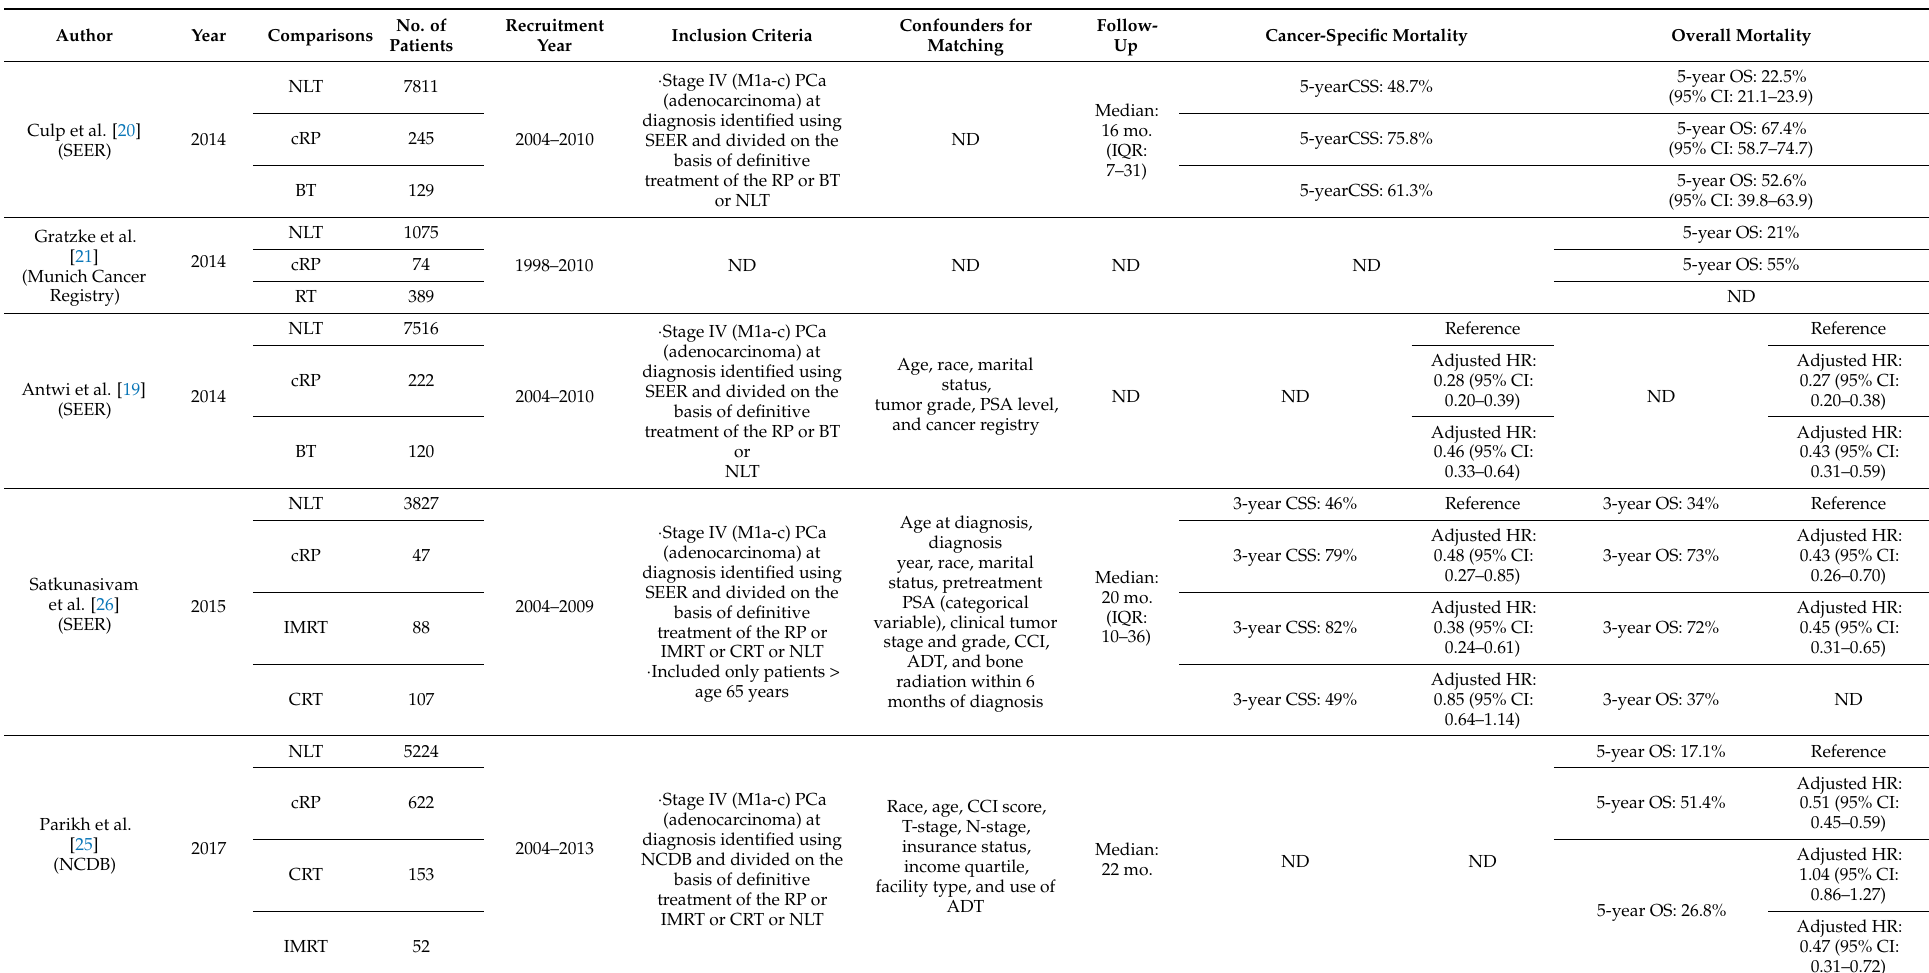
Table 1. Demographics and oncologic outcomes of population-based